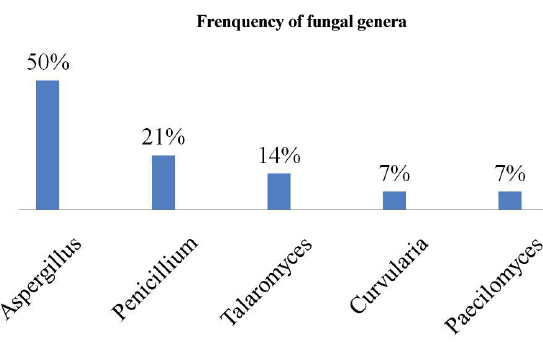
Figure 4 - Frequency of fungal genera found in the air of the analyzed environments of the